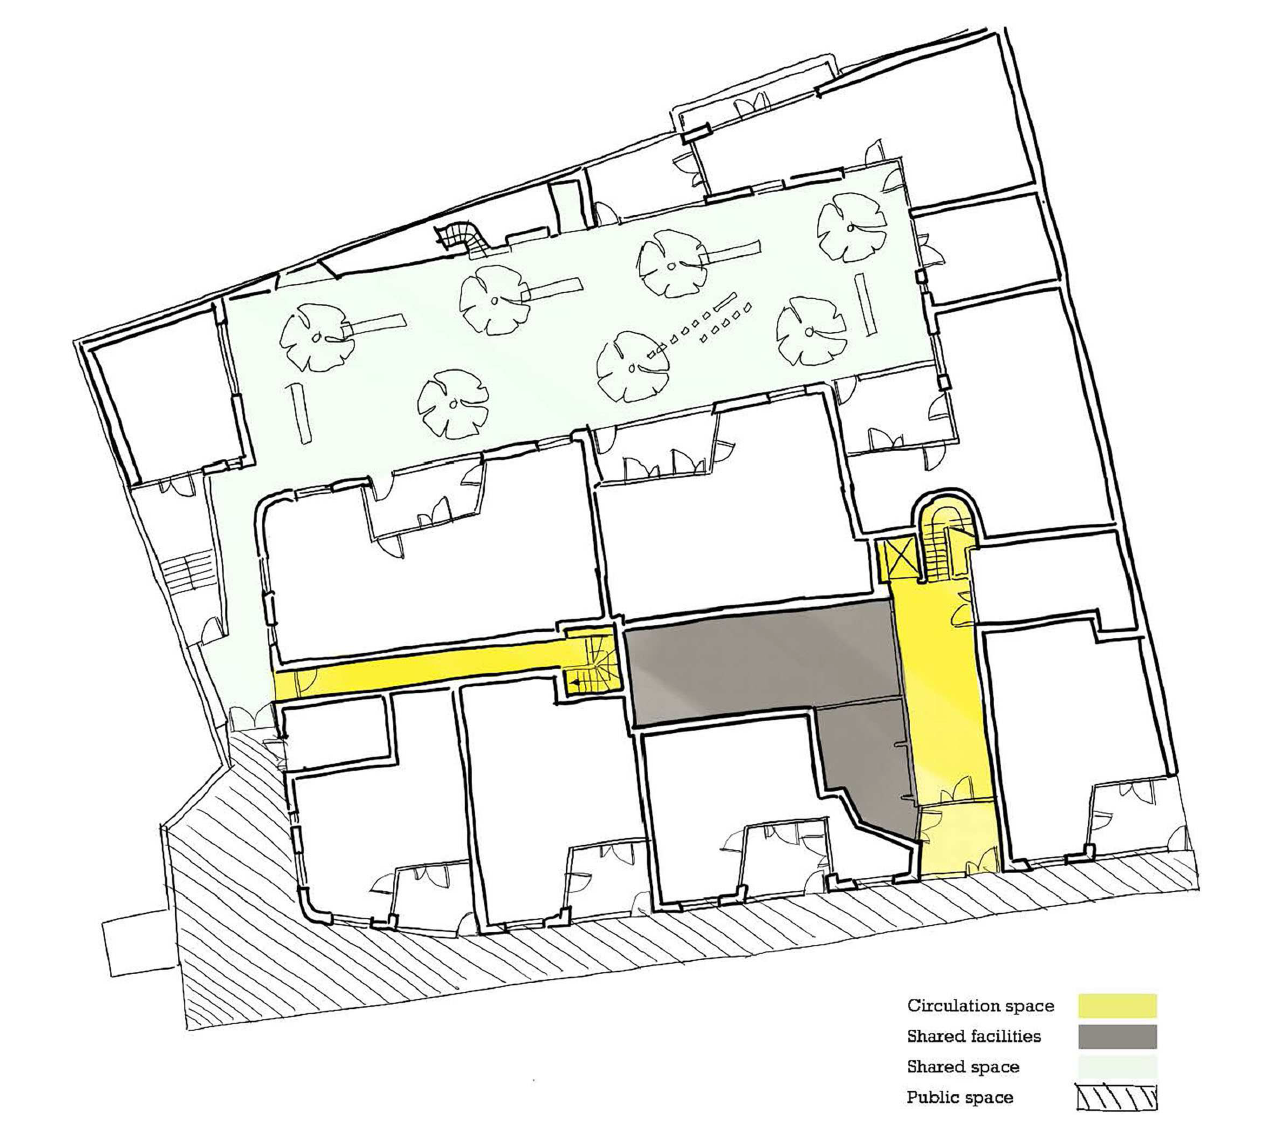
FIGURE4 Ground floor plan of 95 Peckham